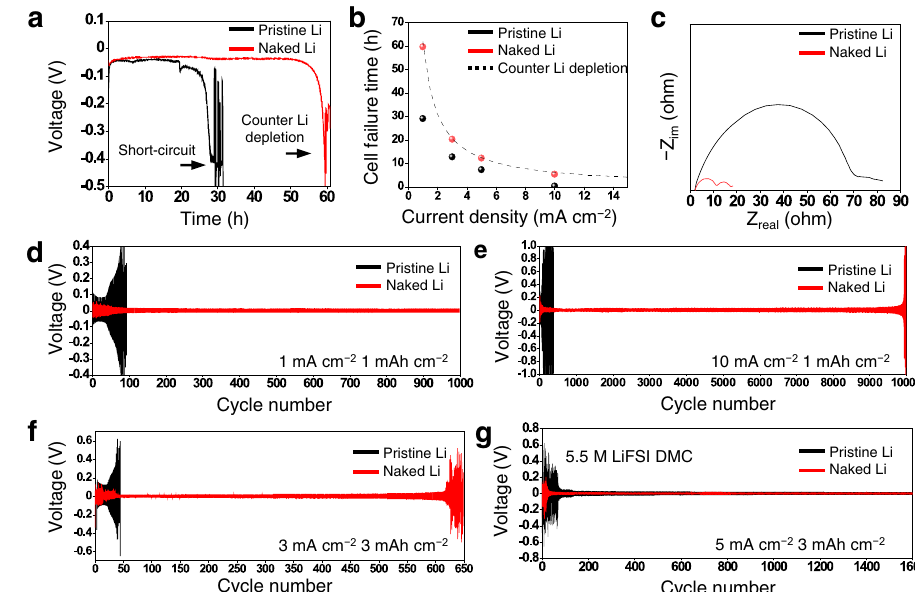
c Nyquist plots of the pristine (black) and naked (red) Li-Li symmetric cells before galvanostatic cycling. Galvanostatic charge-discharge voltage pro fi les of the pris- tine (black) and naked (red) Li-Li symmetric cells with operating conditions of d 1mAcm − 2 , 1mAh cm − 2 , e 10mAcm − 2 , 1mAh cm − 2 , f 3mAcm − 2 , 3mAh cm − 2 , and g 5mAcm − 2 , 3mAh cm − 2 . Electrolytes: 1M LiPF 6 in EC/DEC (50/50=v/v) with 10 wt % FEC for d − f , and 5.5M LiFSI in DMC for g